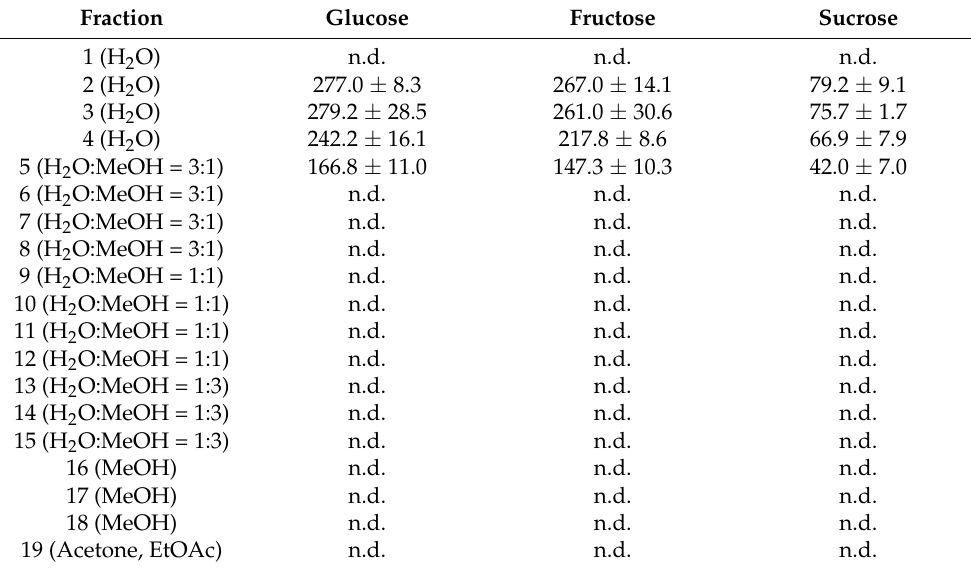
Table 2. Sugar content of fractions from water extracts of V. virgatum stems (mg/g (dry weight of fraction)).